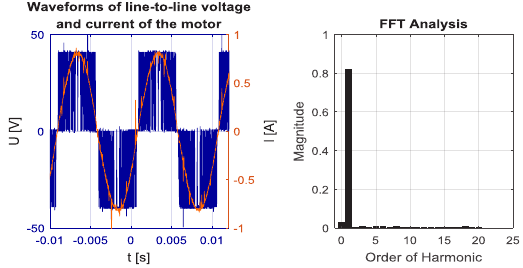
Fig. 3. The waveforms of the line-to-line voltage and phase current for the single-phase motor at frequency of 100 Hz and corresponding FFT current analysis.